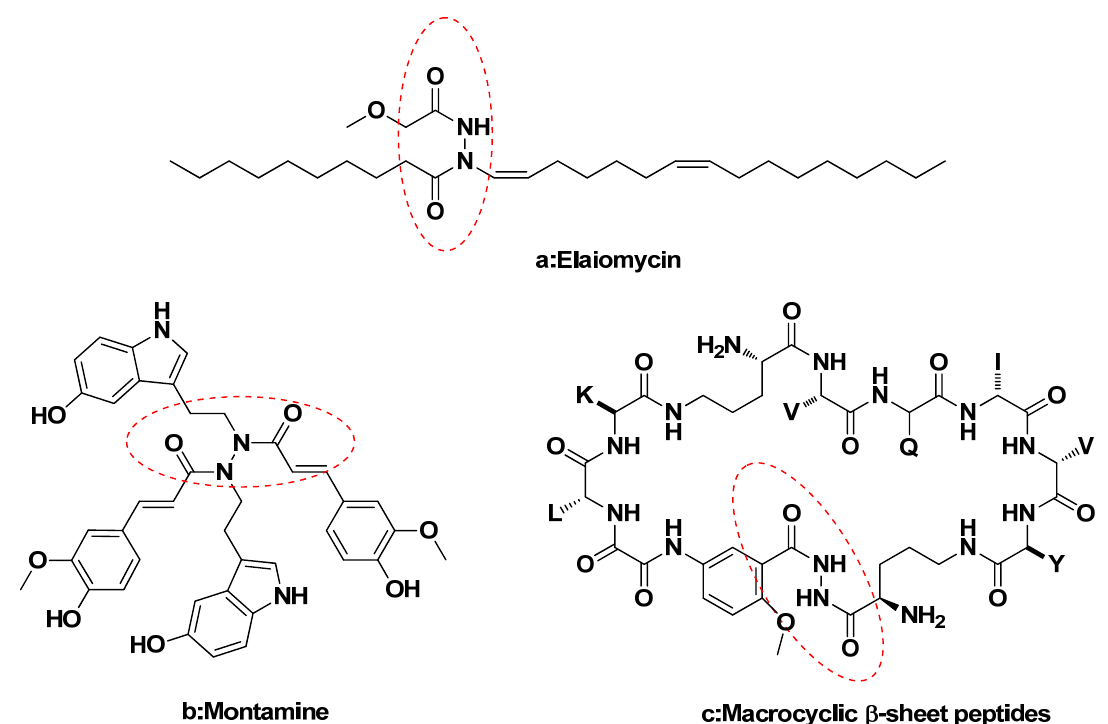
Figure 1. The natural products containing acylhydrazine